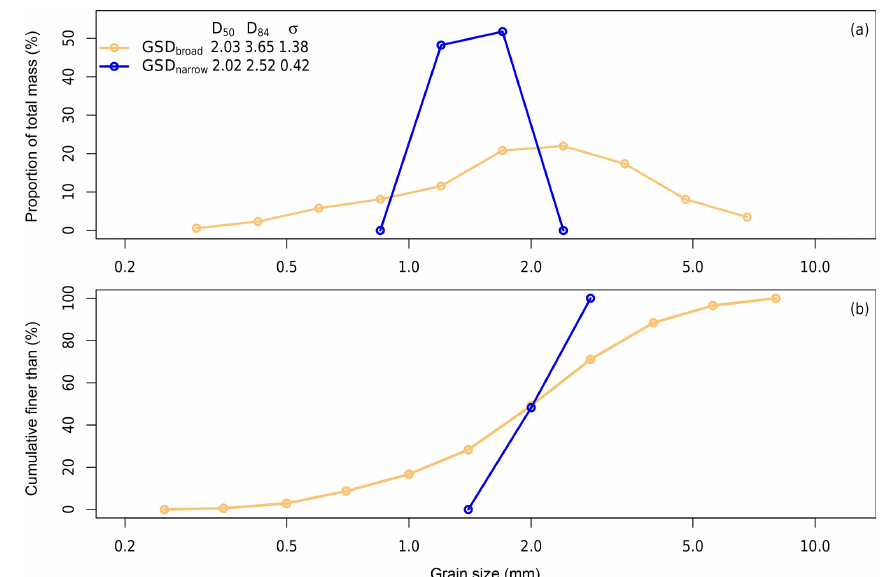
Figure 2. Grain size distributions for half-phi classes (a) individually and (b) cumulatively. Grain size metrics are shown in mm.